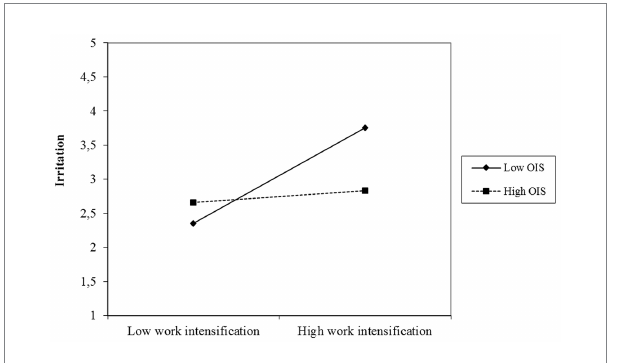
FIGURE 3 Moderation effect of organizational instrumental support on the work intensification – exhaustion